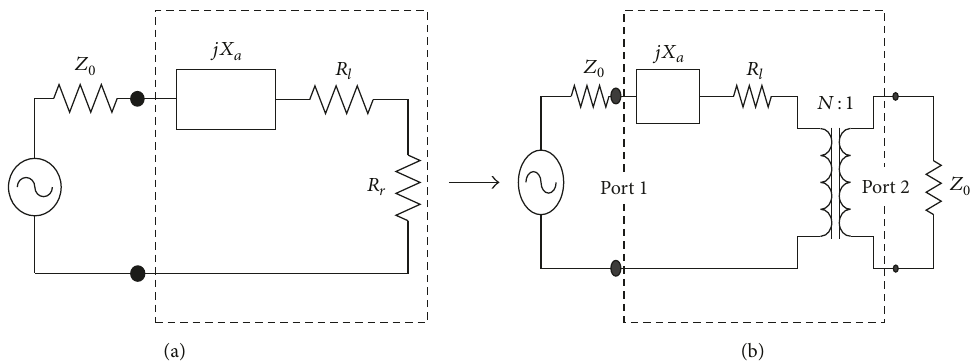
Figure 3: The equivalent circuit of an electrically small antenna; (b) two-port representation of an antenna (radiation resistance replaced with a transformer of free space) (valid at a single